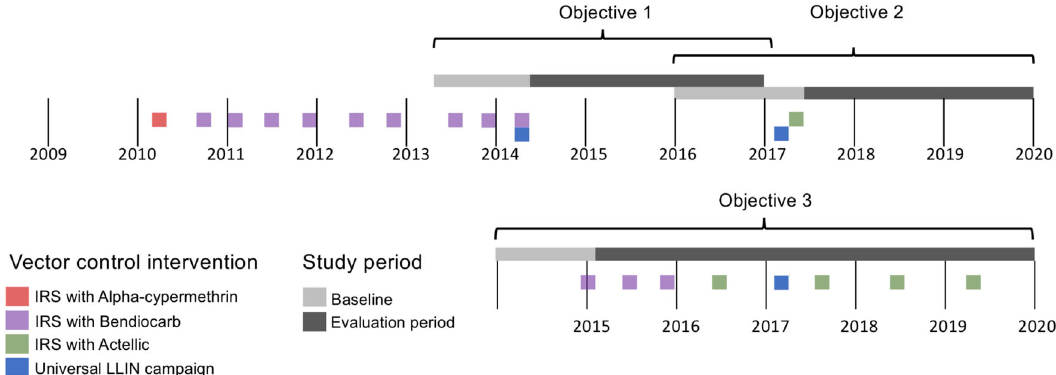
Fig. 2 Timeline summarizing the dates of indoor residual spraying (IRS) campaigns, baseline, and evaluation periods. Objective 1 is to assess the impact of